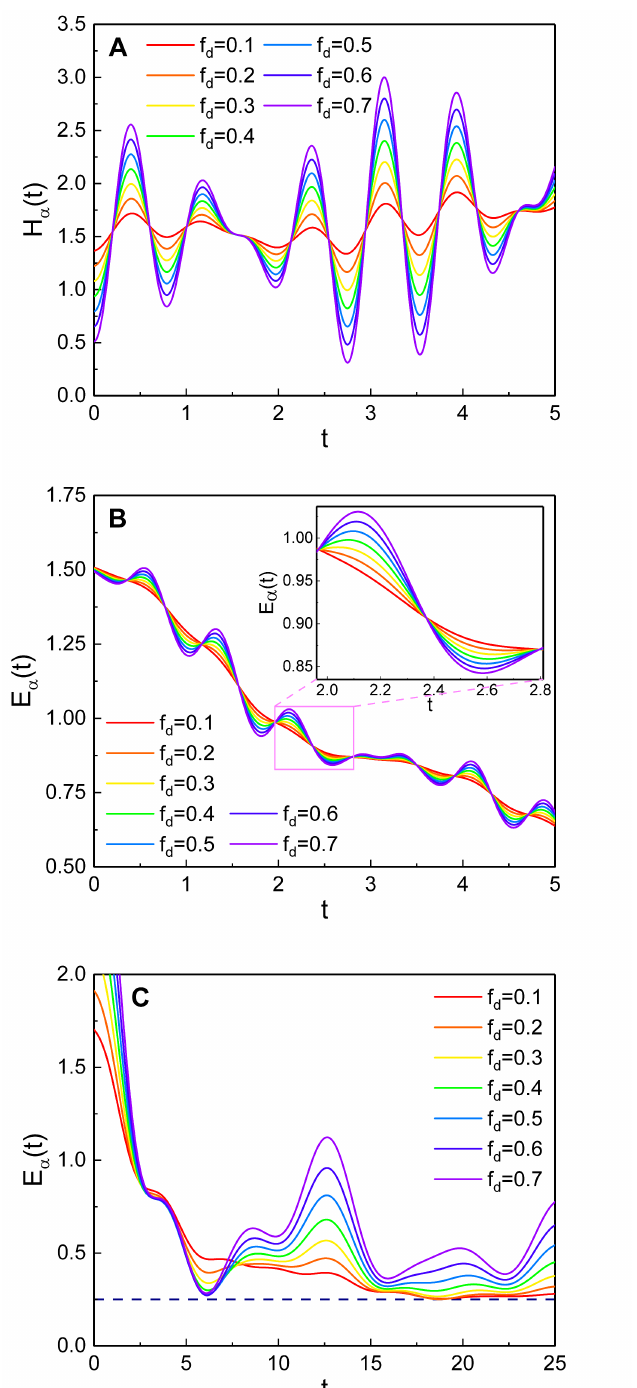
Figure 2. The time evolution of H α ( A ) and E α ( B , C ) depending on f d , where ω = 8 for ( A , B ), while ω = 0.5 for ( C ). The values that we have used are γ e = 0.2, ω e = 1, ϕ = 0, α 0 = 1, m = 1, and ¯ h = 1. The difference of ( C ) from ( B ) is only the value of the taken ω